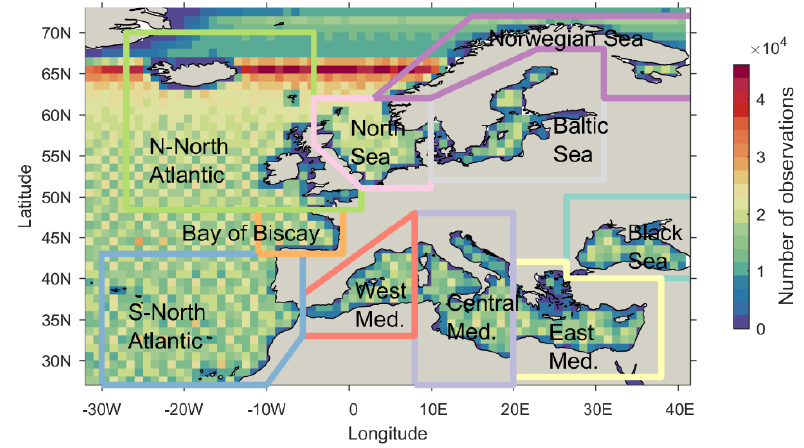
Figure 1. Study area with the 10 oceanographic regions defined for the analysis. The colour scale indicates the number of altimetry observations in each 1° × 1° latitude and longitude cell for the period: 1993–2016.